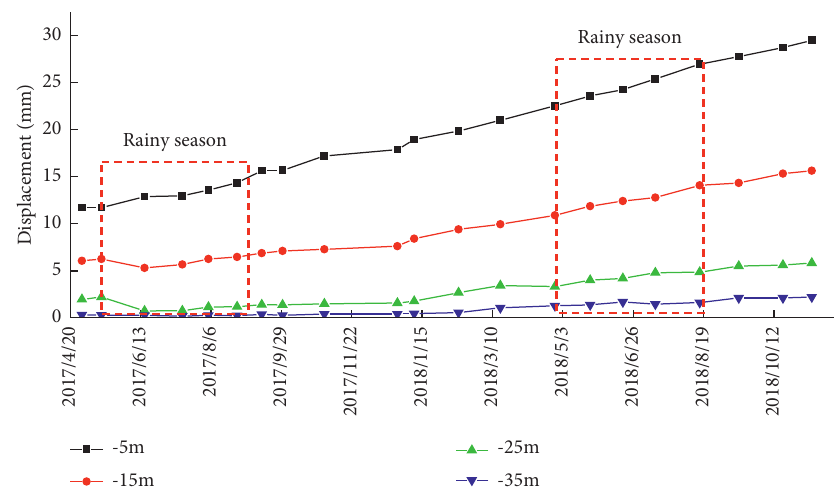
Figure 4: Displacement curve of 29# antislide pile at same depths during the rainy